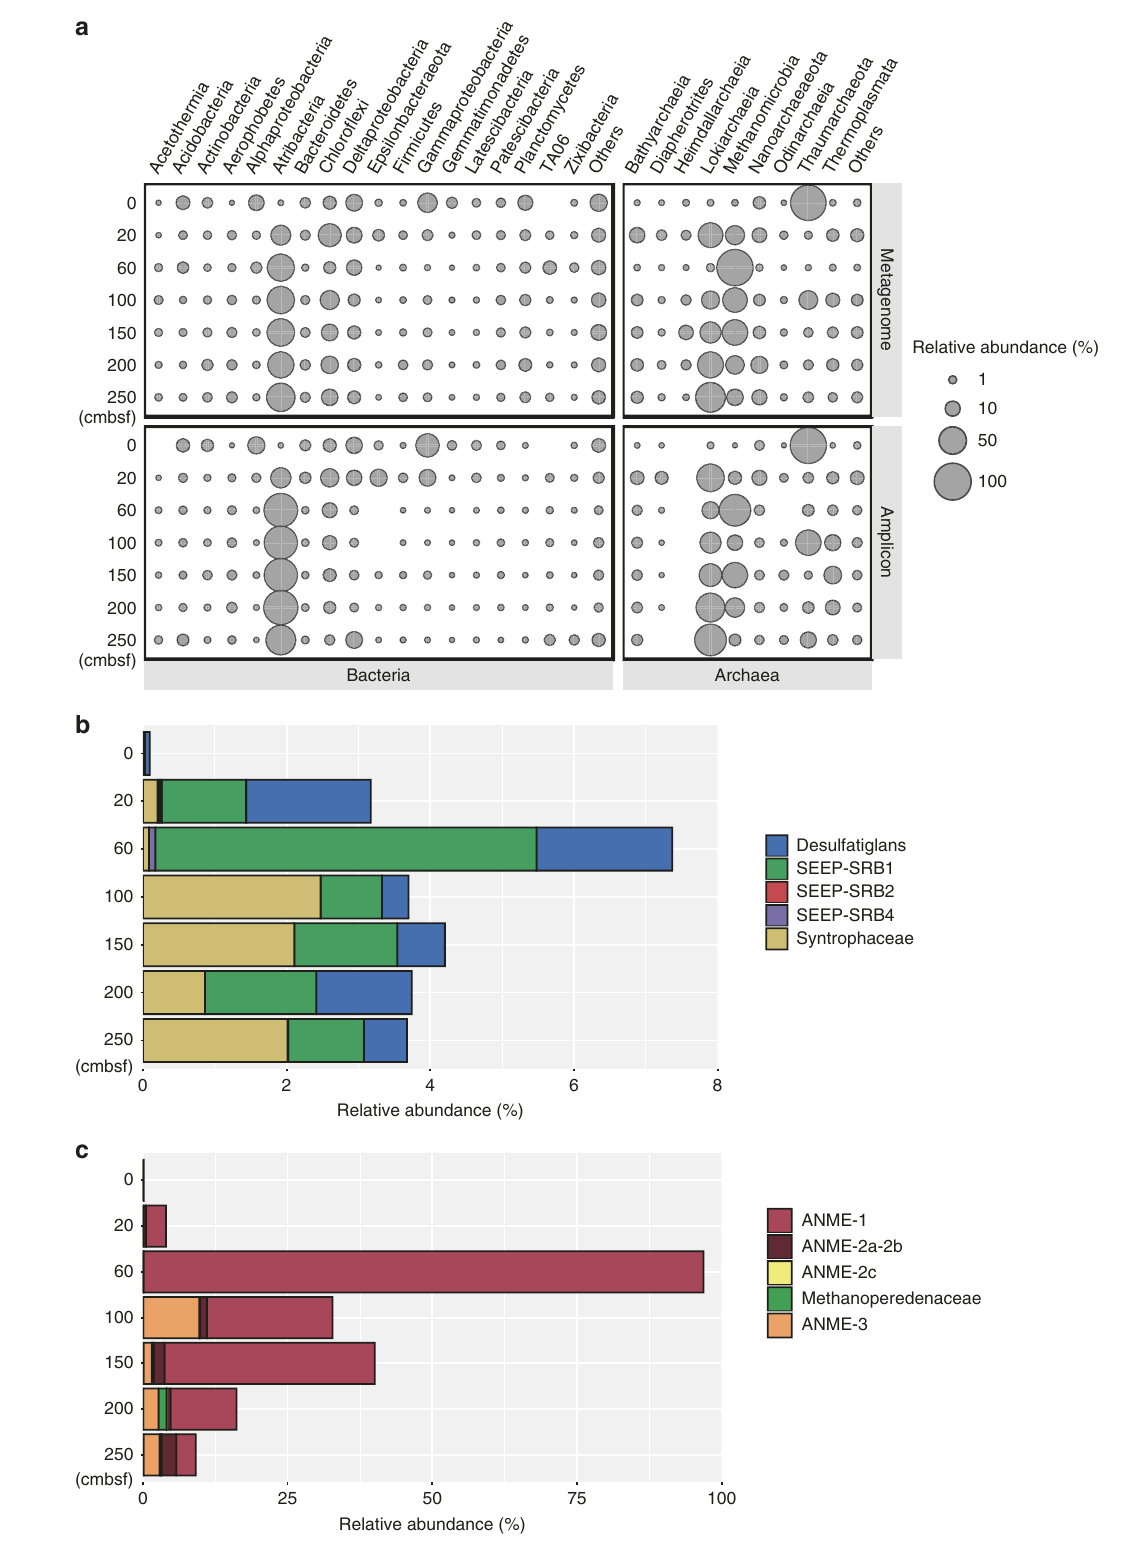
Fig. 2 Compositions of microbial communities across sediment depths based on 16S rRNA genes. a Relative abundances of bacterial and archaeal taxa at different sediment depths. Top panels: 16S rRNA gene fragments derived from metagenomic libraries using the phyloFlash pipeline. Bottom panels: 16S rRNA gene amplicons. Bacterial groups are shown on the left and archaeal groups are shown on the right. b Relative abundances of anaerobic bacterial hydrocarbon degraders among bacteria inferred from 16S rRNA gene fragments in metagenomes. c Relative abundances of anaerobic archaeal hydrocarbon degraders among archaea inferred from 16S rRNA gene fragments in